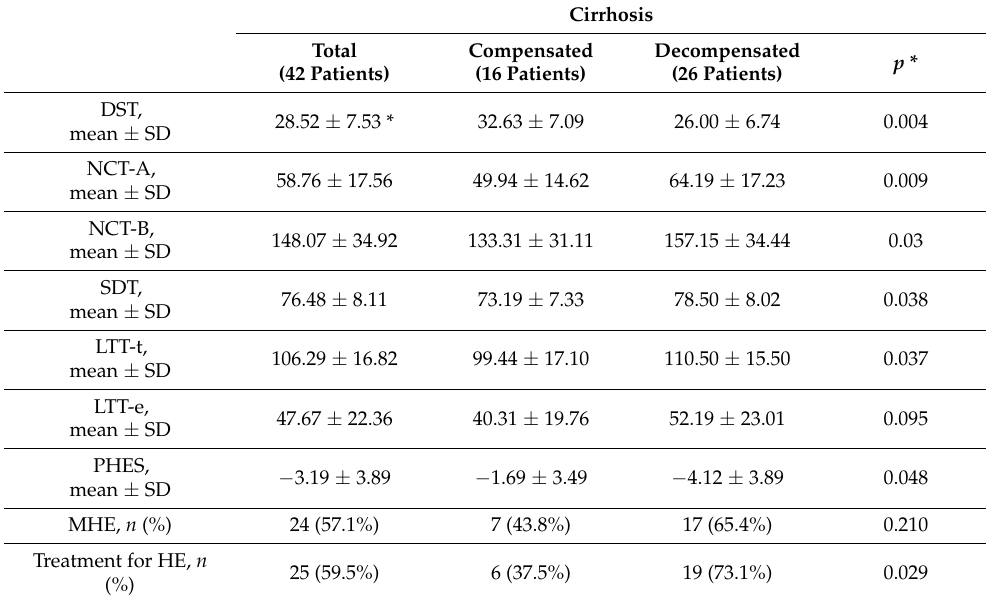
Cirrhosis Total Compensated Decompensated (42 Patients) (16 Patients) (26 Patients)